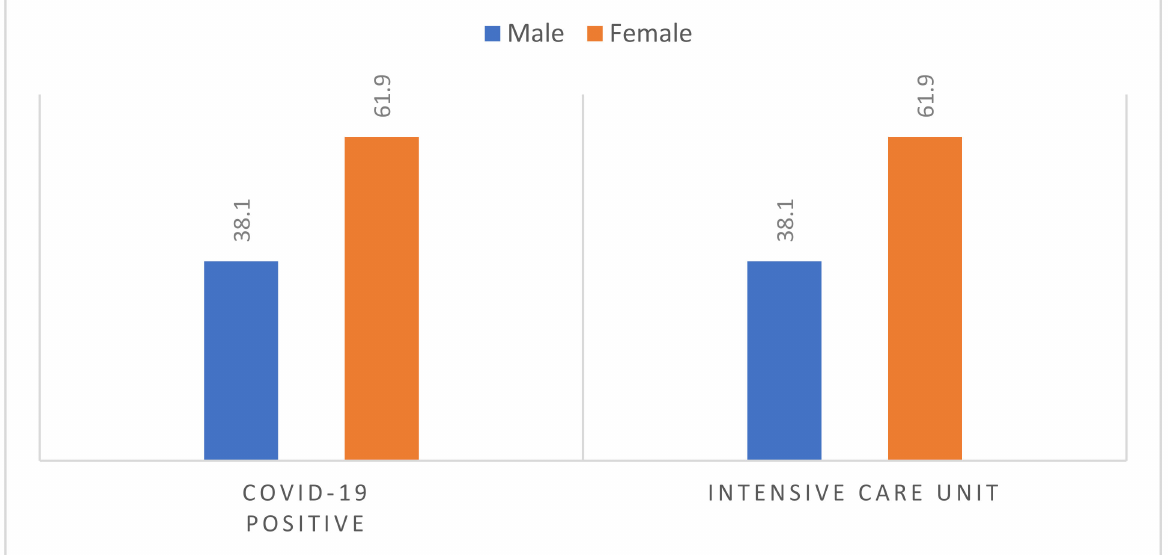
Figure 1. Distribution of the study participants according to the results of the COVID-19 test and departments by